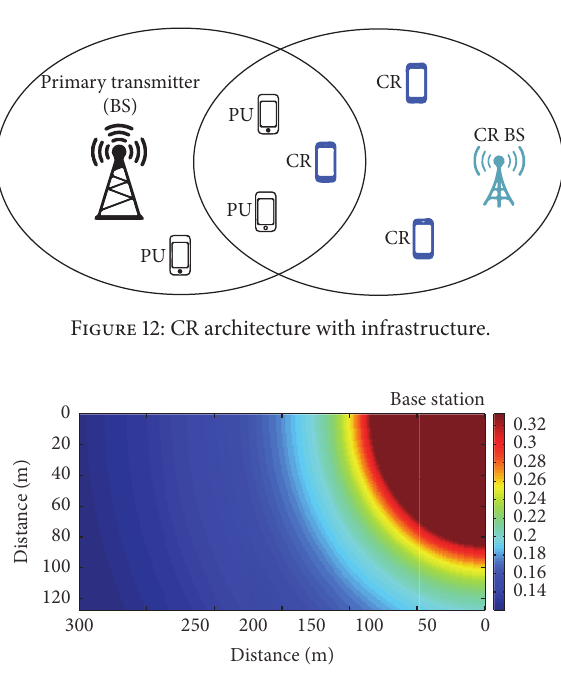
Figure 13: Duty cycle for the proposed model in the GSM